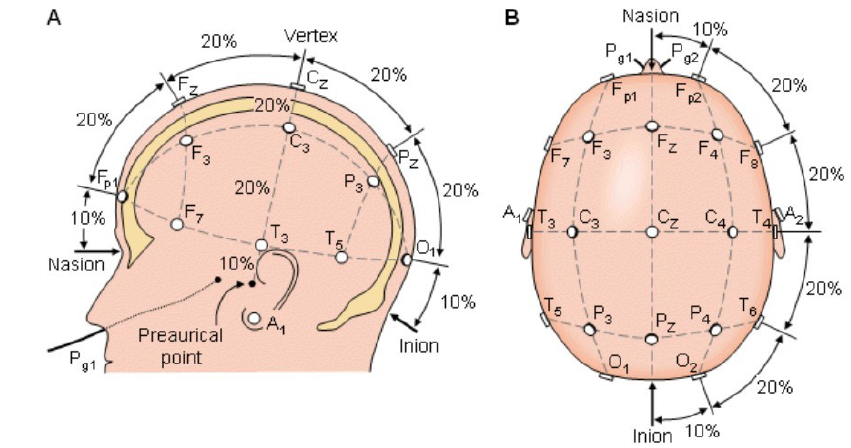
Figure 3. The international 10–20 system seen from ( A ) left and ( B ) above the head